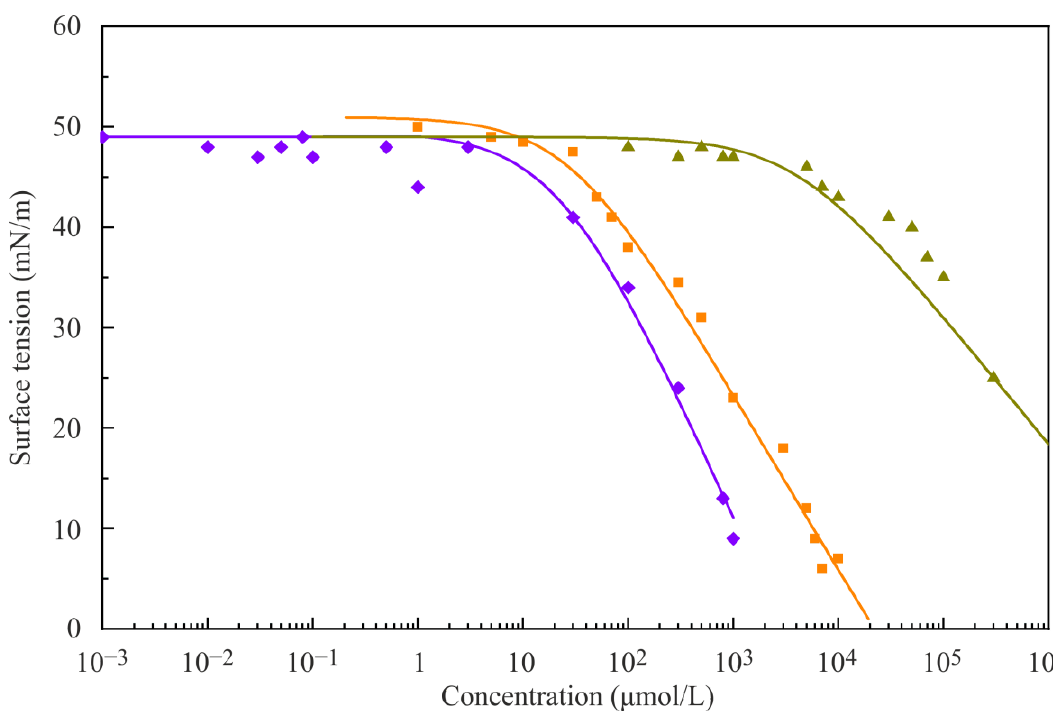
Figure 5. Equilibrium interfacial tension measured by profile analysis tensiometry (PAT) at the solution/hexane interface as a function of the total bulk concentration c of the mixtures ( (cid:7) ) NaC 12 SO 4 + C 6 TAB and the individual surfactants ( (cid:4) ) NaC 12 SO 4 and ( ) C 6 TAB; the solid lines are the fitting results for a Frumkin adsorption model given by Equations (1)–(3).